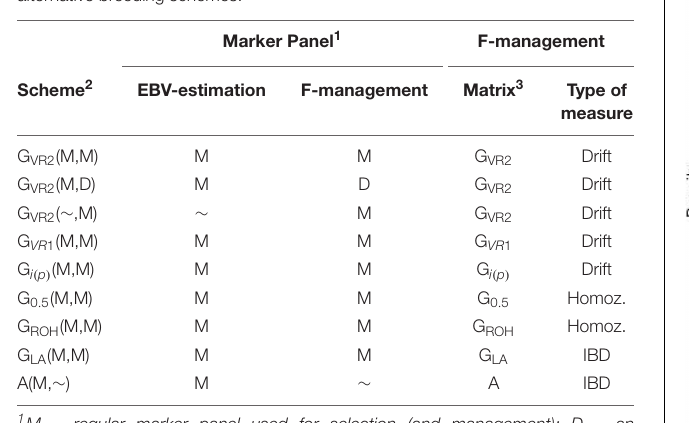
TABLE 1 | The relationship matrices and marker panels that were used for the alternative breeding schemes.